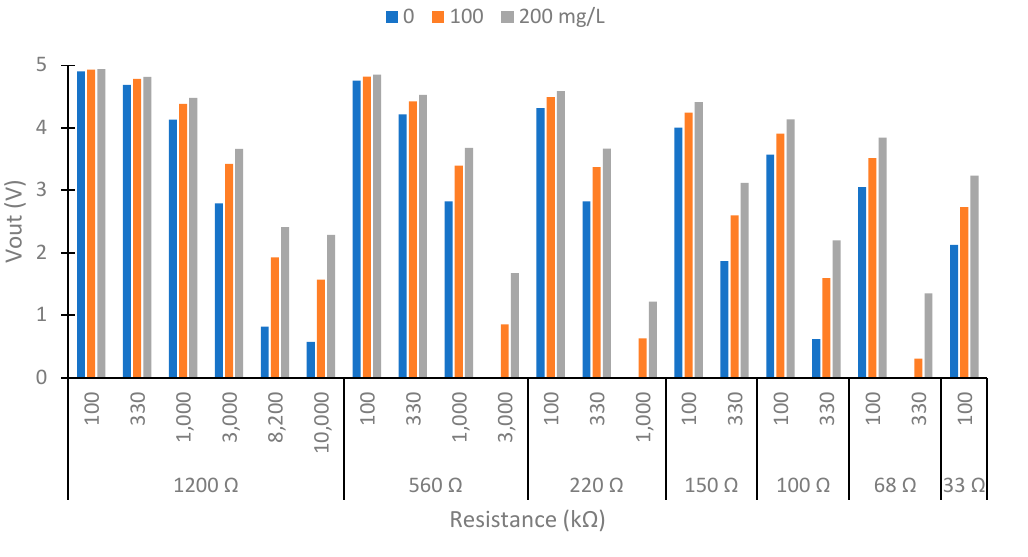
Figure 5. Test of the configuration of IR circuits. LED resistance 1200 Ω , 560 Ω , 220 Ω , and 150 Ω Figure 5. Test of the con fi guration of IR circuits. LED resistance 1200 Ω , 560 Ω , 220 Ω , and 150 Ω at at 180 ◦ . 180°.